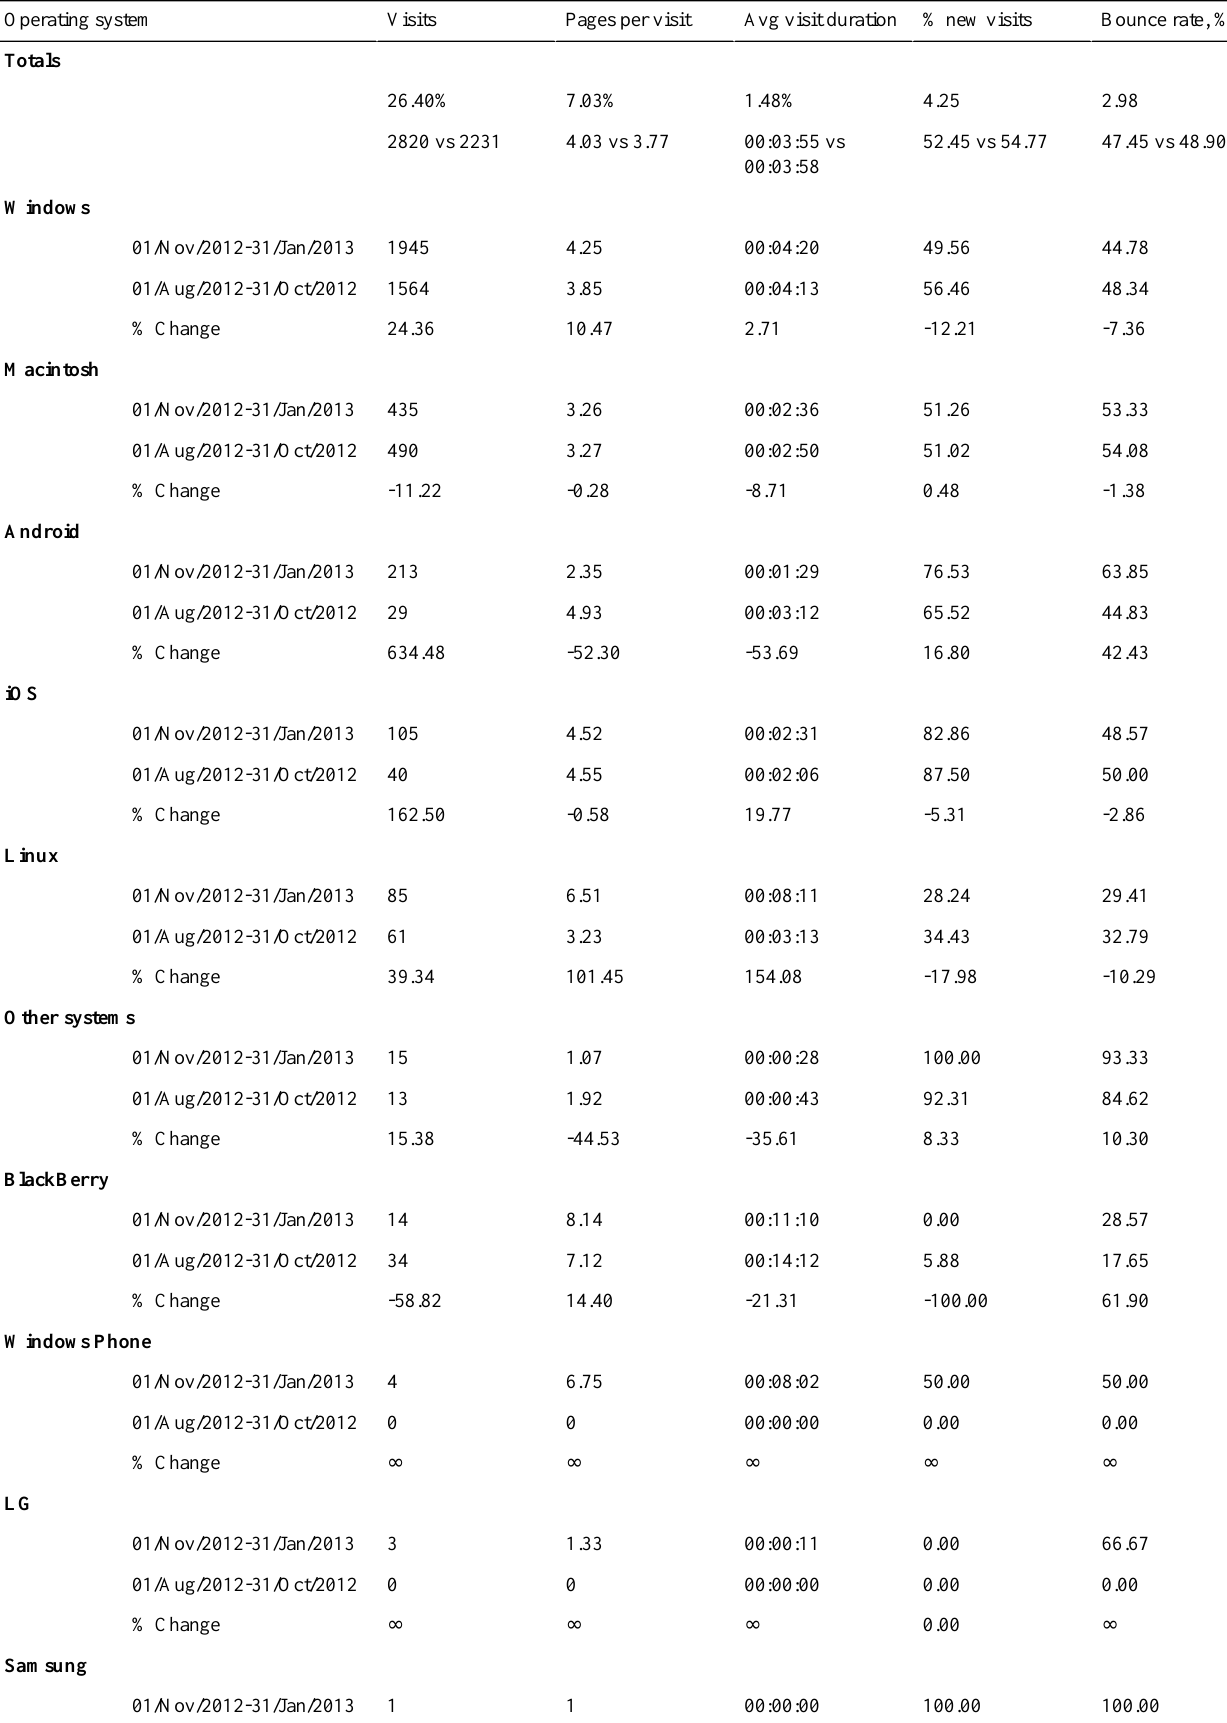
Table 1. Comparison of website visits between the pre-mobile and post-mobile